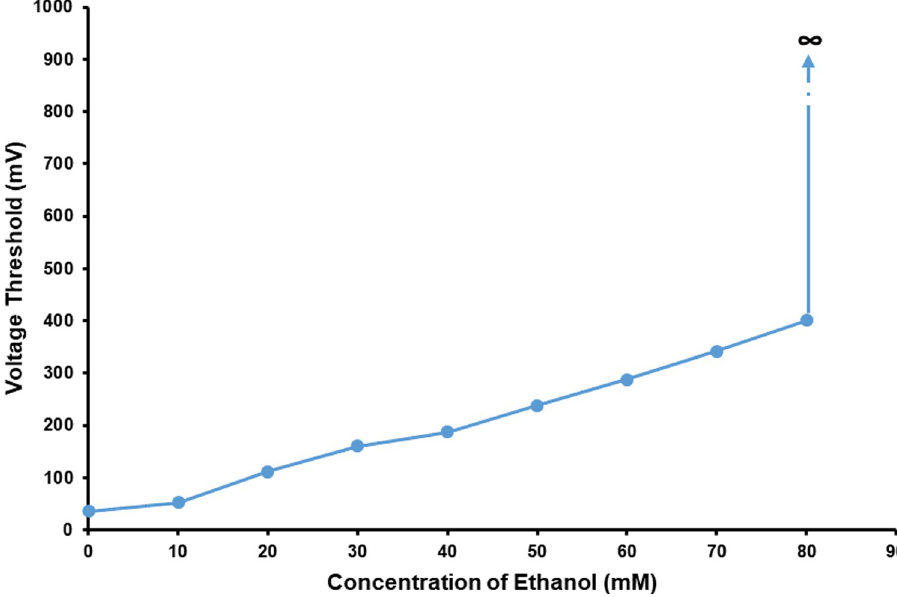
Fig 4. The V Th of PC12 quasi-neuronal networks under the effect of ethanol in different concentrations ( n =